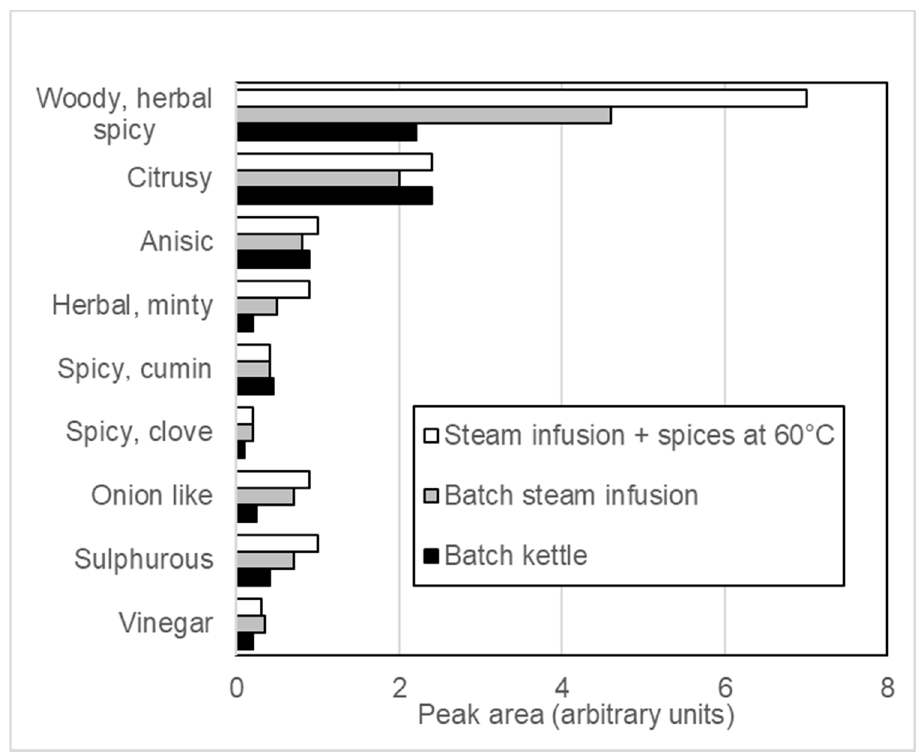
Figure 4. The cumulative peak area totals for a GC-MS analysis of curry sauce batches that have been cooked by either conventional steam jacket (“Batch Kettle”) or Steam Infusion with all of the ingredients batched in the kettle; a Steam Infusion cook with the spices added (entrained) from a hopper mid process at 60 °C batch temperature during the cook is also included.